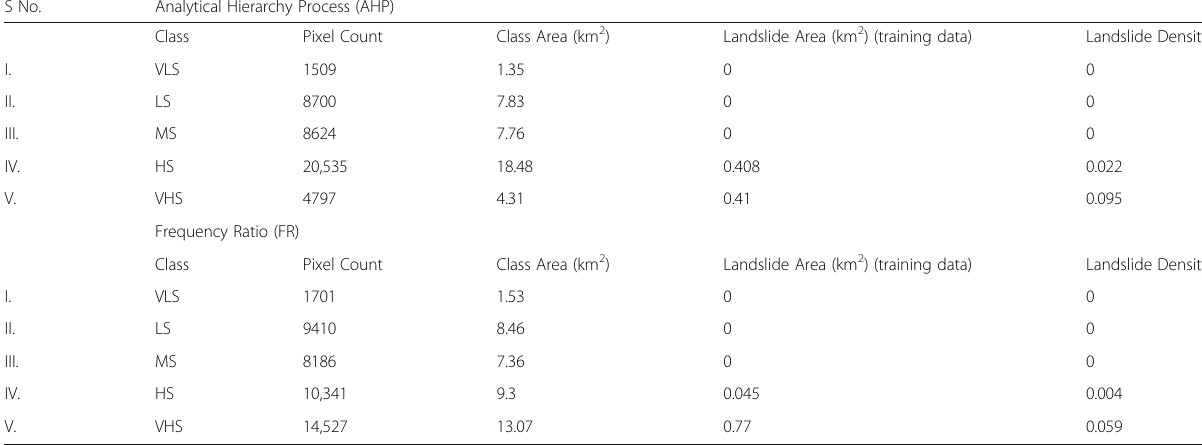
Table 6 Shows the landslide area along with the landslide density distribution in the susceptibility classes of LSZ maps S